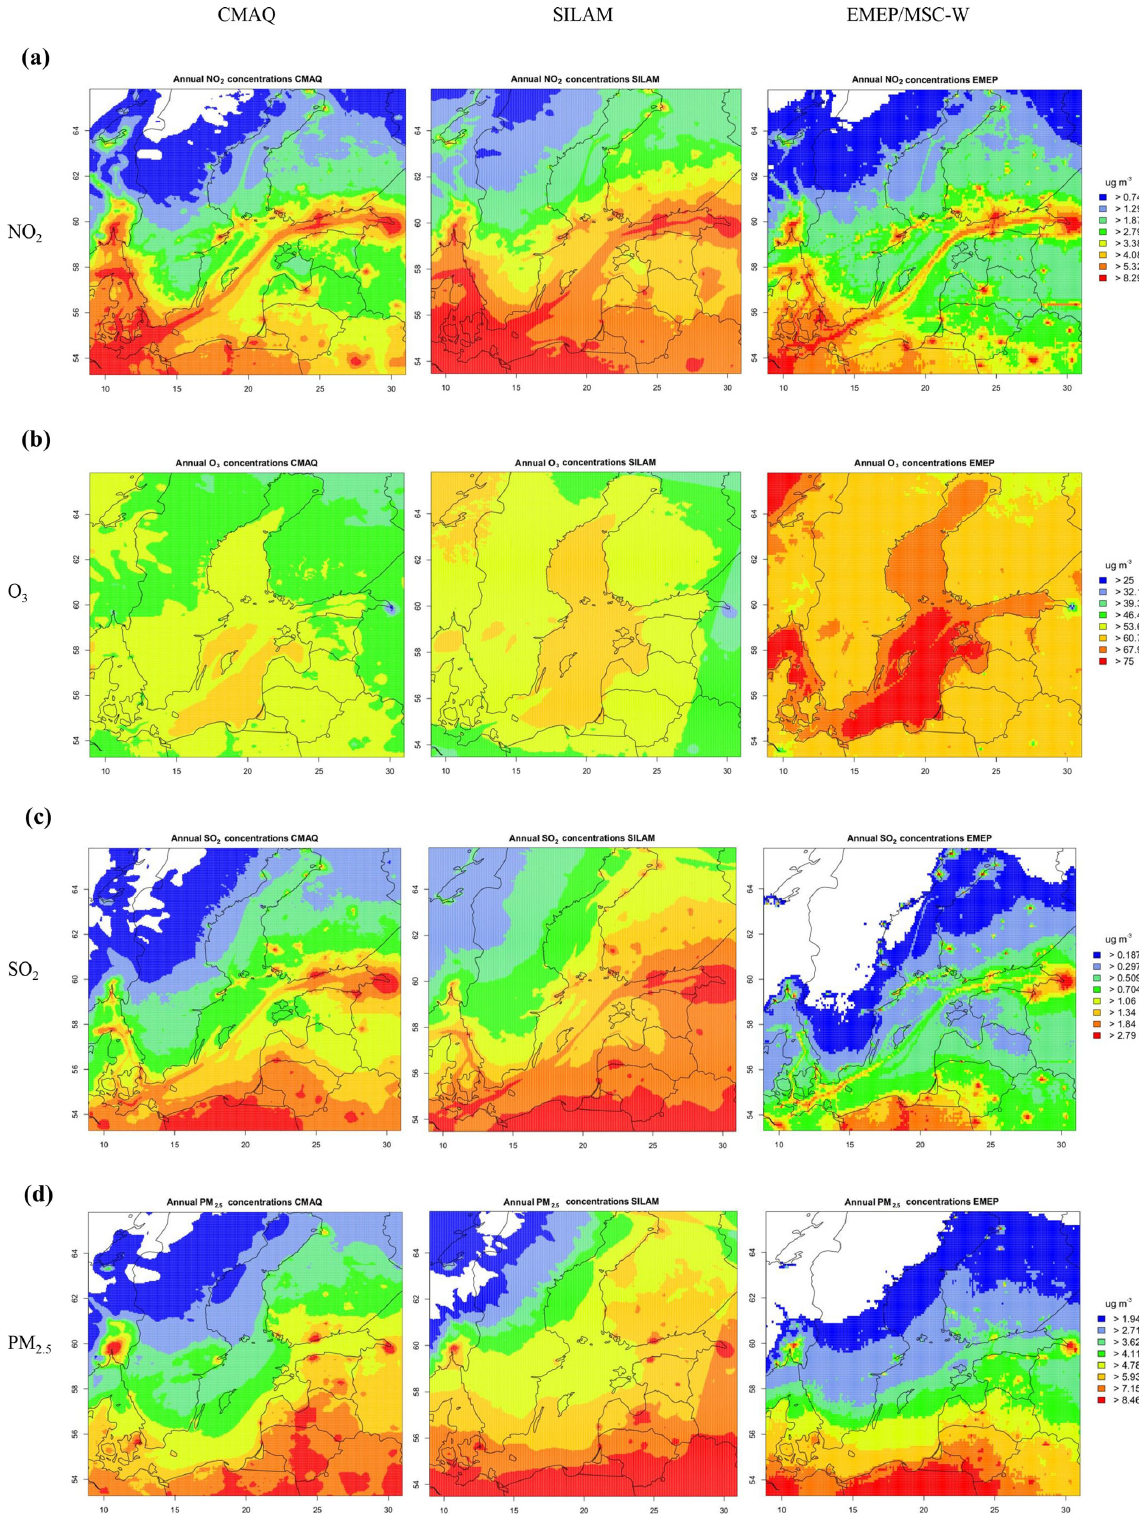
Figure 8. Comparison of the spatial distribution of annual mean concentrations (µgm − 3 ) from CMAQ (left column), SILAM (middle column) and EMEP (right column) in the Baltic Sea region for (a) O 3 , (b) NO 2 , (c) SO 2 and (d) PM 2 . 5 . Empty areas correspond to concentrations between zero and the lowest value in the